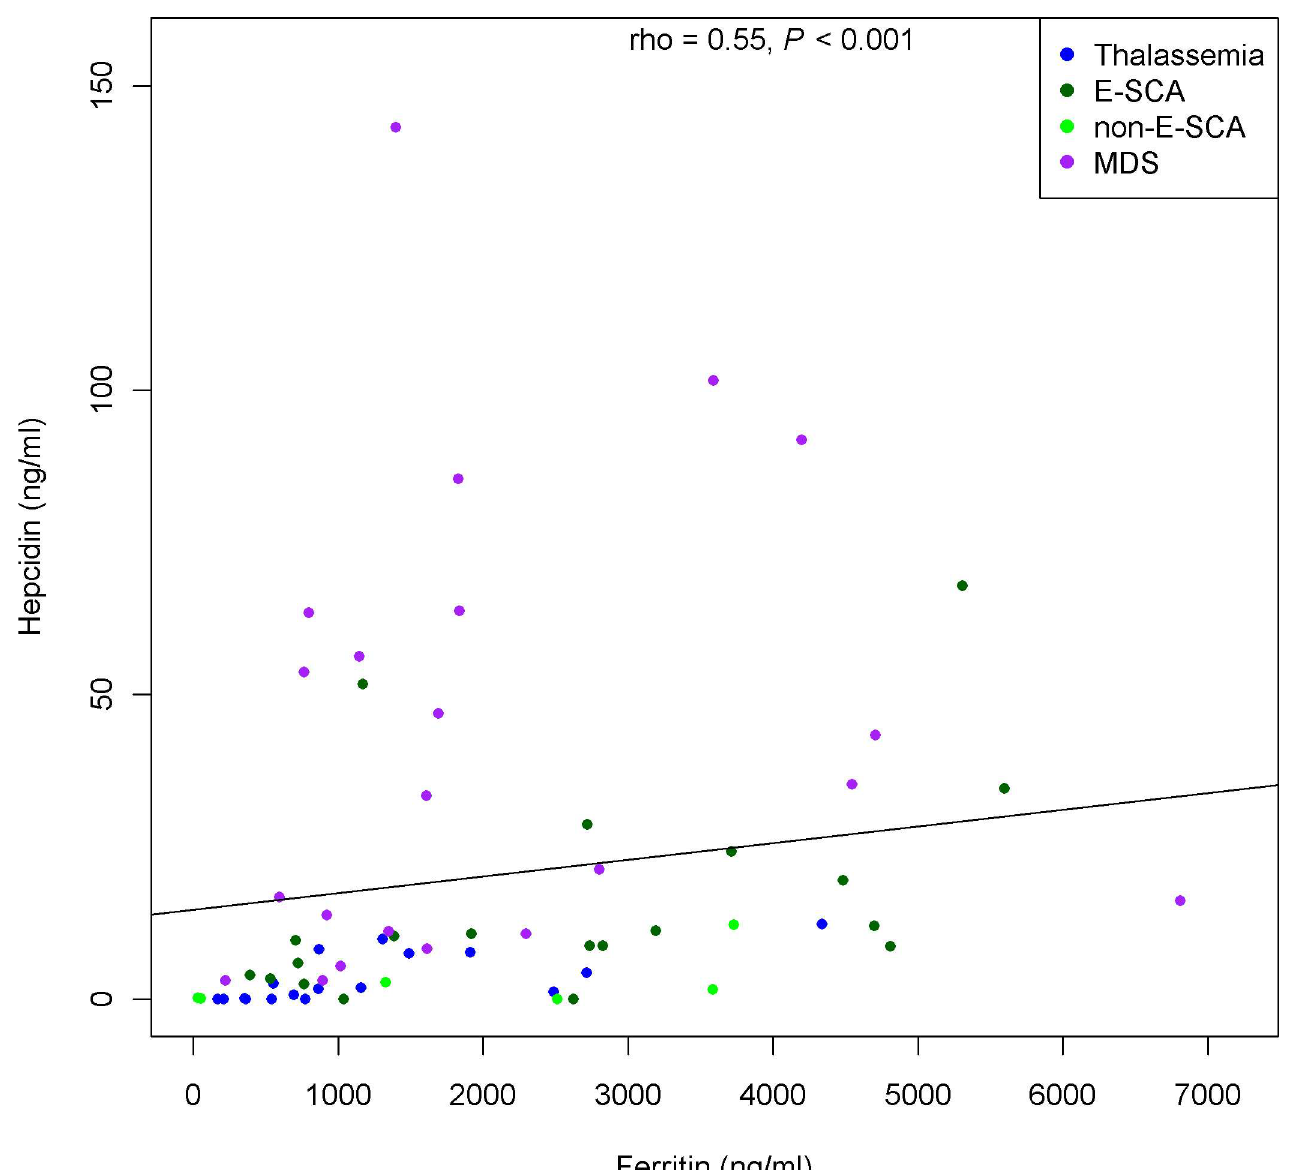
Fig 2. association between hepcidin and ferritin in the global population.